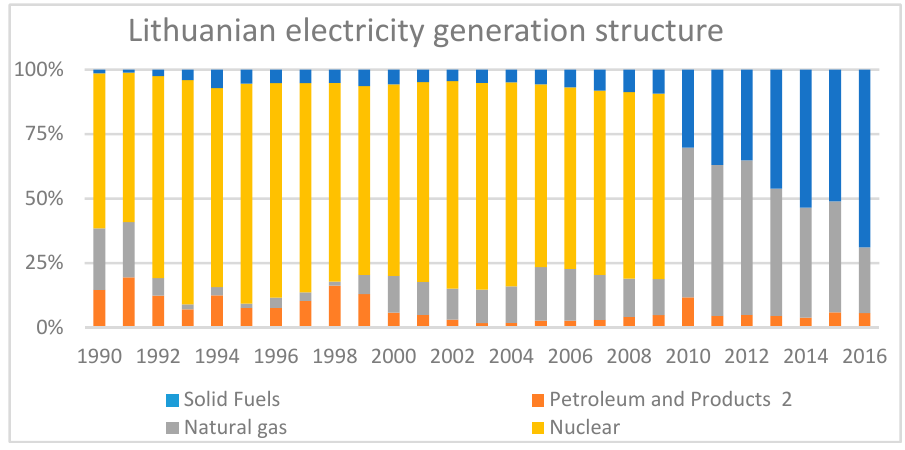
Figure 11. Electricity generation structure dynamics in Lithuania, %. Source: [39].